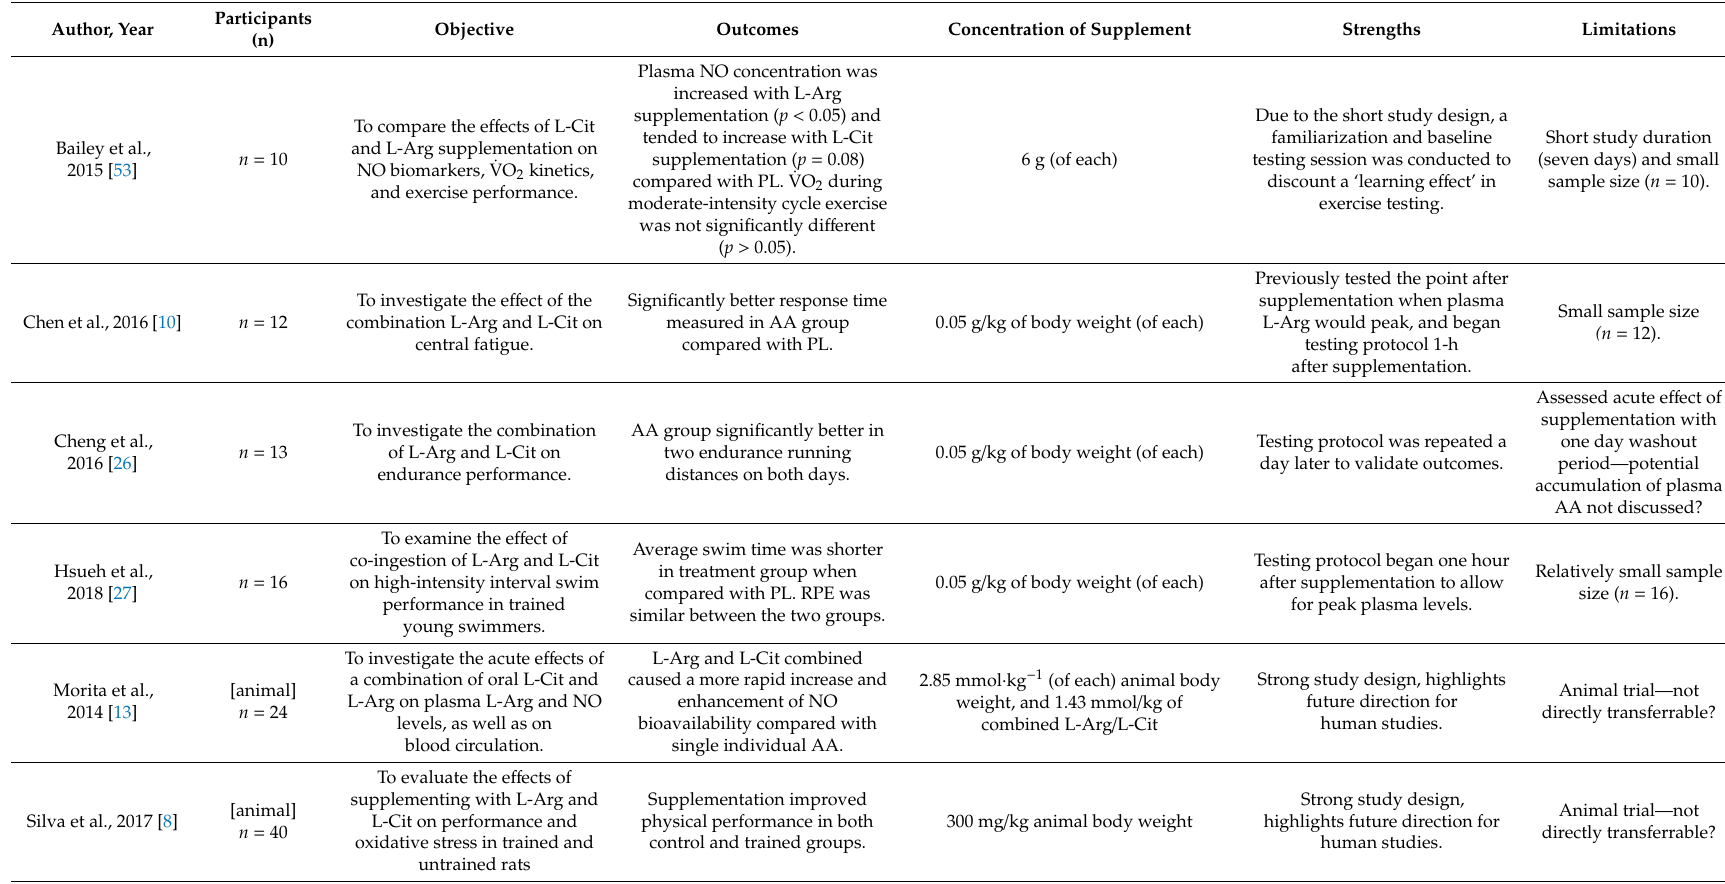
Table 1. Summary of studies which tested L-Arginine and L-Citrulline in combination in humans and animal